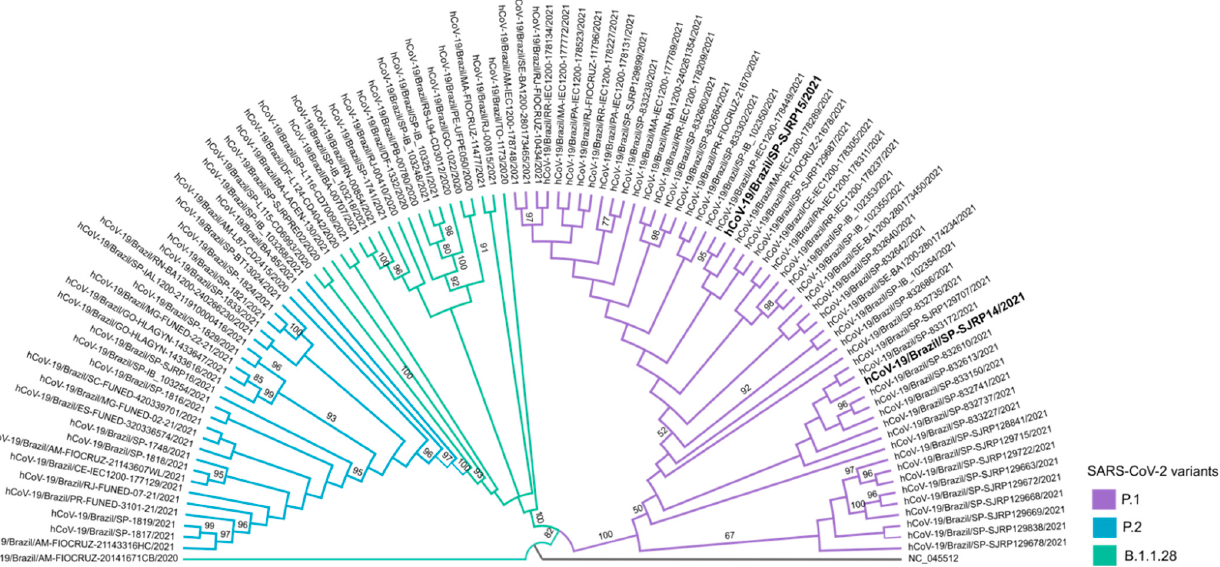
Figure 3. Phylogenetic relationship of hCoV-19/Brazil/SP-SJRP14/2021 and hCoV-19/Brazil/SP-SJRP15/2021 (in bold). Maximum-likelihood tree was built in IQ-TREE (v. 2.1.3), using GTR+F+I as a nucleotide substitution model. Bootstrap: 1000. Table 2. Non-synonymous changes identified in the whole-genomes of hCoV-19/Brazil/SP-SJRP14/2021(EPI_ISL_1754186) and hCoV-19/Brazil/SP-SJRP15/2021 (EPI_ISL_1941583). In bold: mutations of